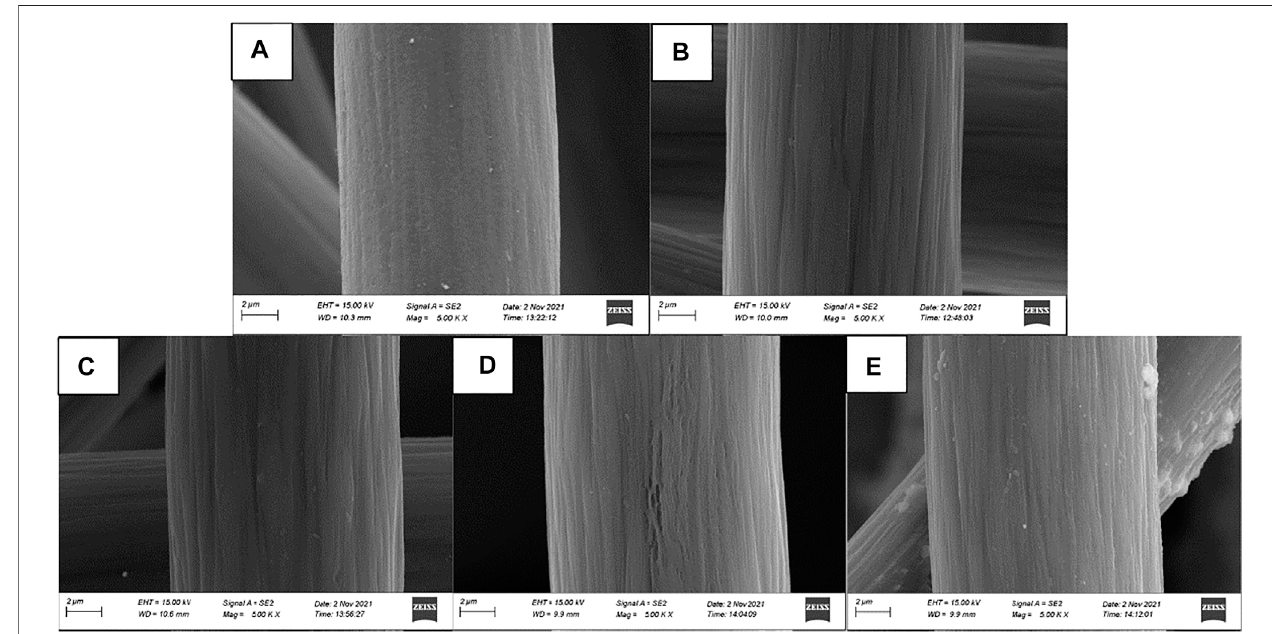
FIGURE 2 | 5.00 KX Scanning Electron Micrograph (SEM) (A) , untreated graphite felt (B) , heat treated graphite felt (C) , heat treated graphite felt impregnated with 0.1 M